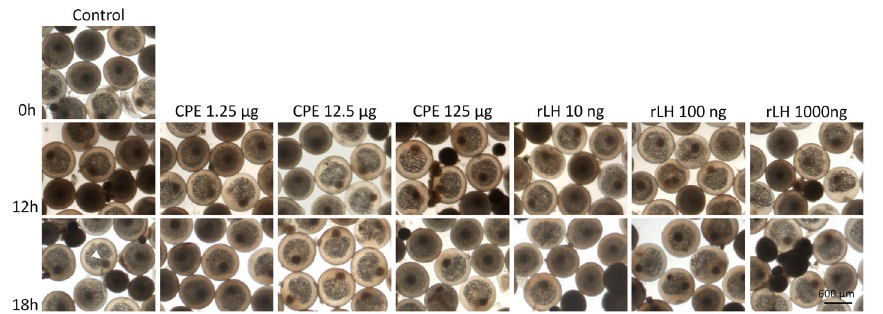
Figure 3. Maturing eel oocytes when treated with various dosages of CPE (0, 1.25, 12.5 and 125 µg mL − 1 ) and rLH (0, 10, 100 and 1000 ng mL − 1 ) in vitro at the start of incubation (0 h) and after 12 and 18 h of incubation. Oocytes were fixed with Serra’s solution to stain the nucleus (white arrow). Oocytes incubated without hormone (control) had a visible nucleus after 0, 12 and 18 h of incubation. Similarly, oocytes incubated with CPE and rLH still had a visible nucleus showing that both CPE and rLH did not induce GVBD. In addition, the oocyte and lipid diameters did not change over time, neither with treatment. Still, variations in the oocyte and lipid diameters and variations in the position of the nucleus (center and periphery) were observed between oocyte batches of different females but independent of the treatment.